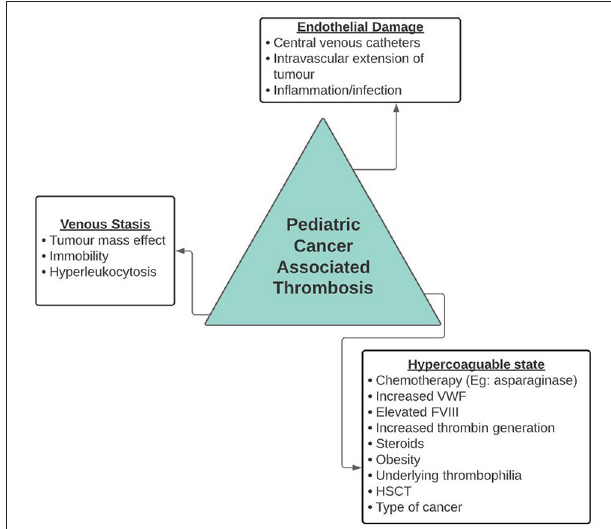
FIGURE 1 | Risk factors for cancer associated